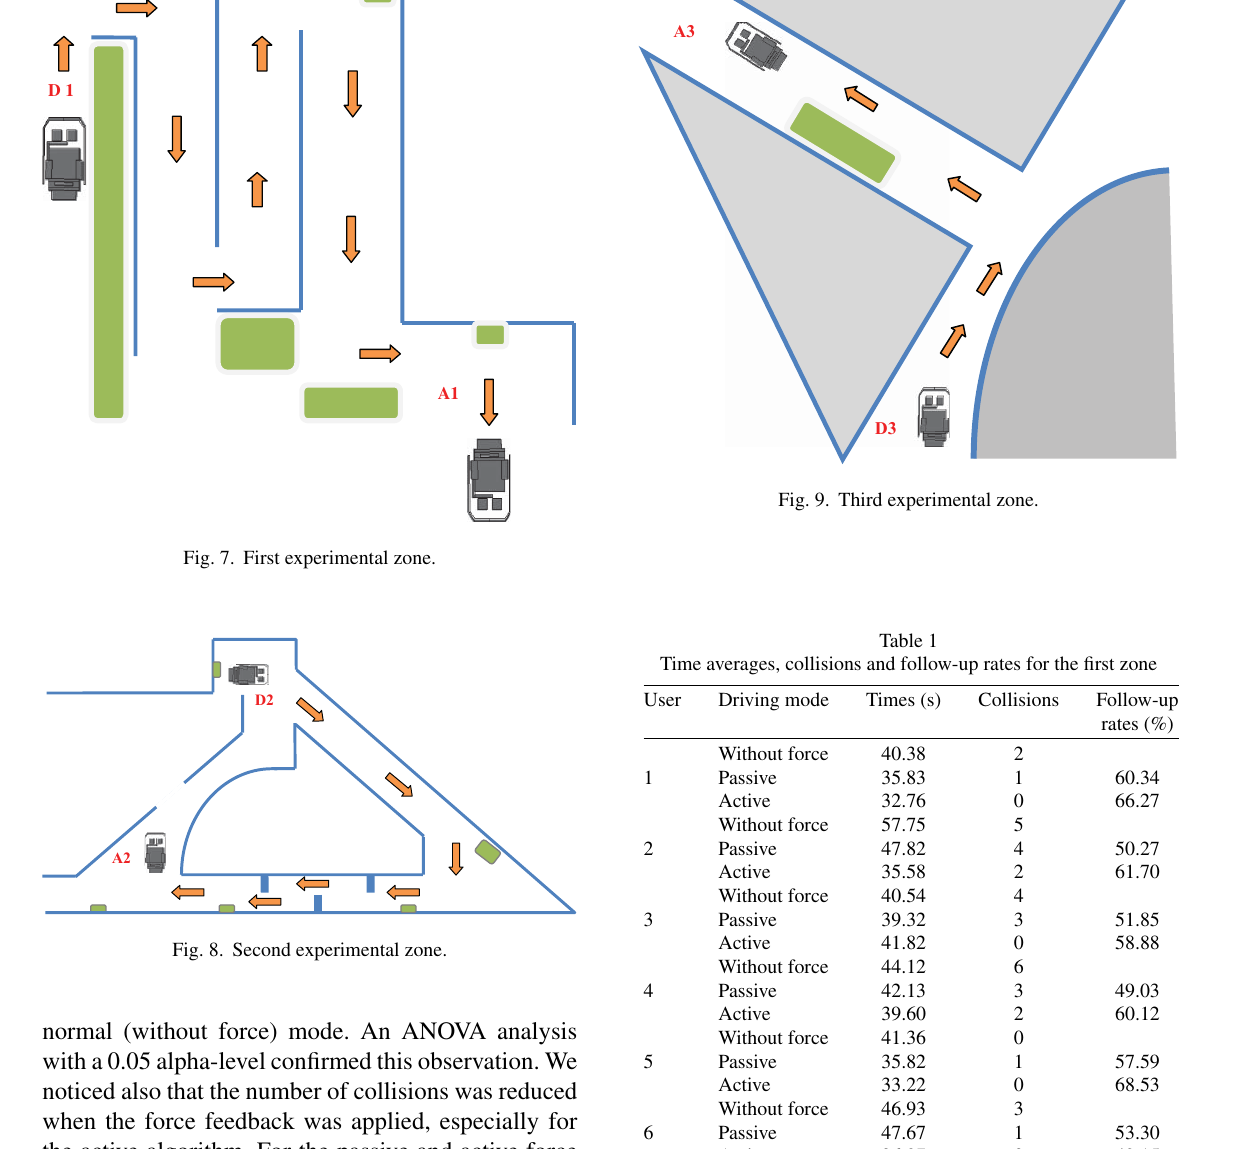
Fig. 9. Third experimental zone.